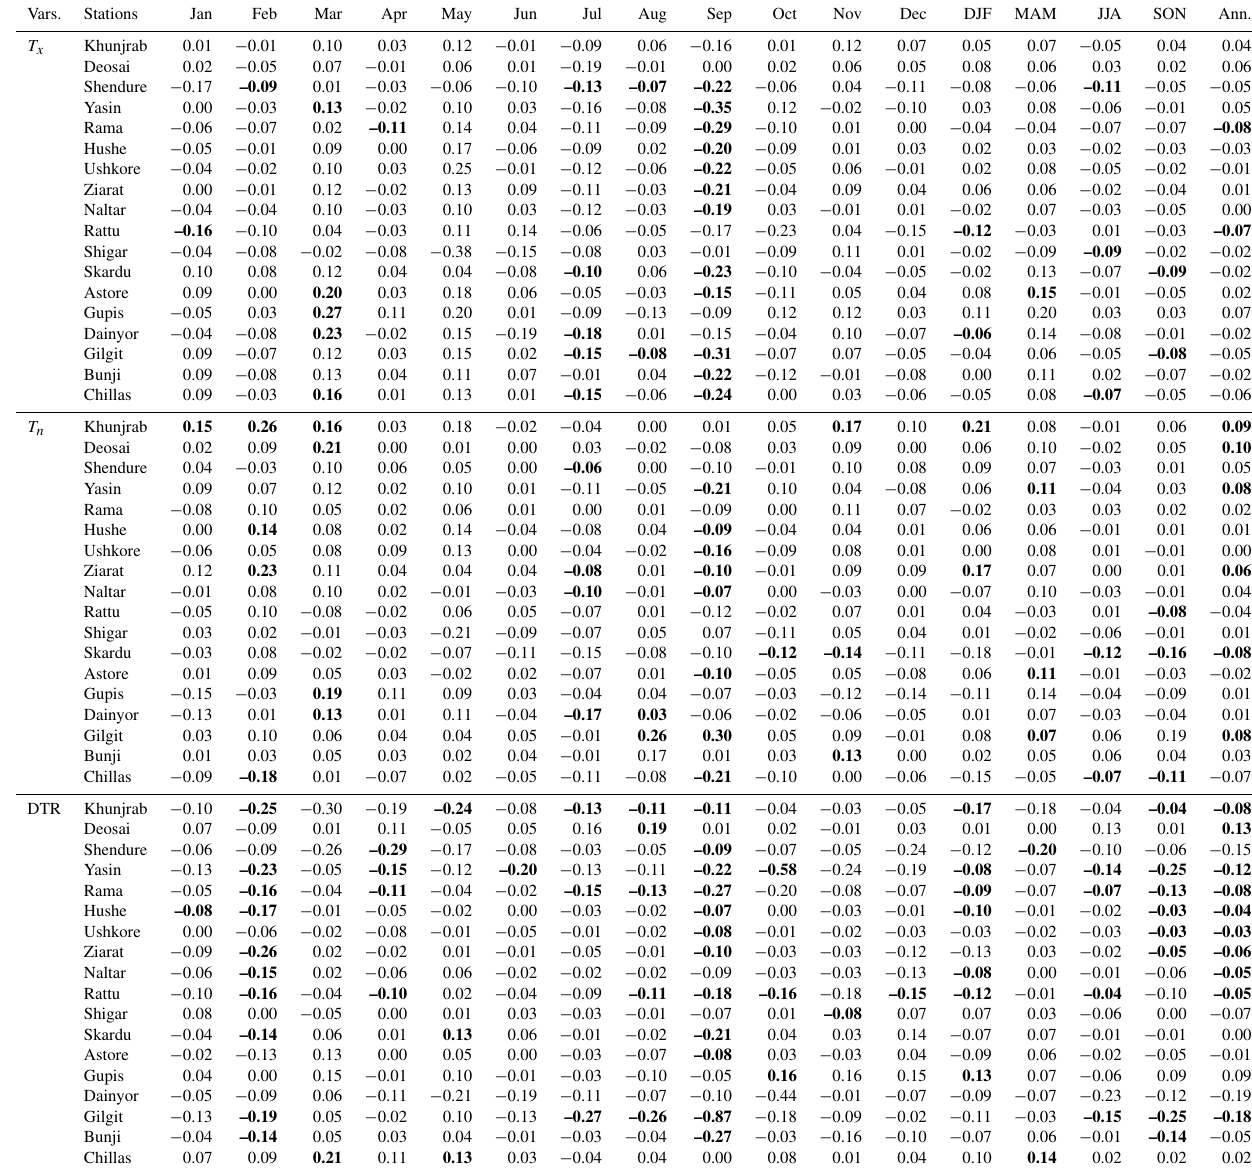
Table 4. Trend for T x , T n and DTR in ◦ C (per unit time) at monthly to annual timescales over the period 1995–2012. Note: stations are given in top to bottom altitude order. Slopes significant at the 90% level are given in